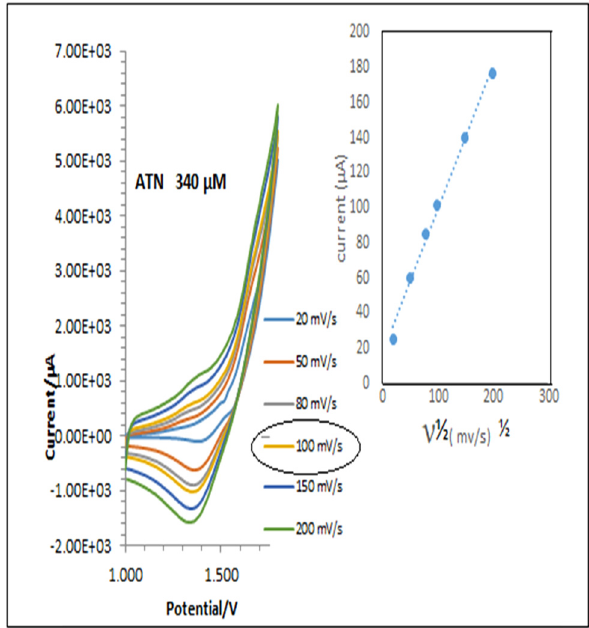
Figure 4: Cyclic voltammograms for 340 µmol L − 1 of ATN in 0.1 mol L − 1 of H 2 SO 4 solution obtained using CPE - I at di ff erent scan rates from 20 to 200 mV s − 1 . Insert: linear dependence of the peak current with ν 1/2